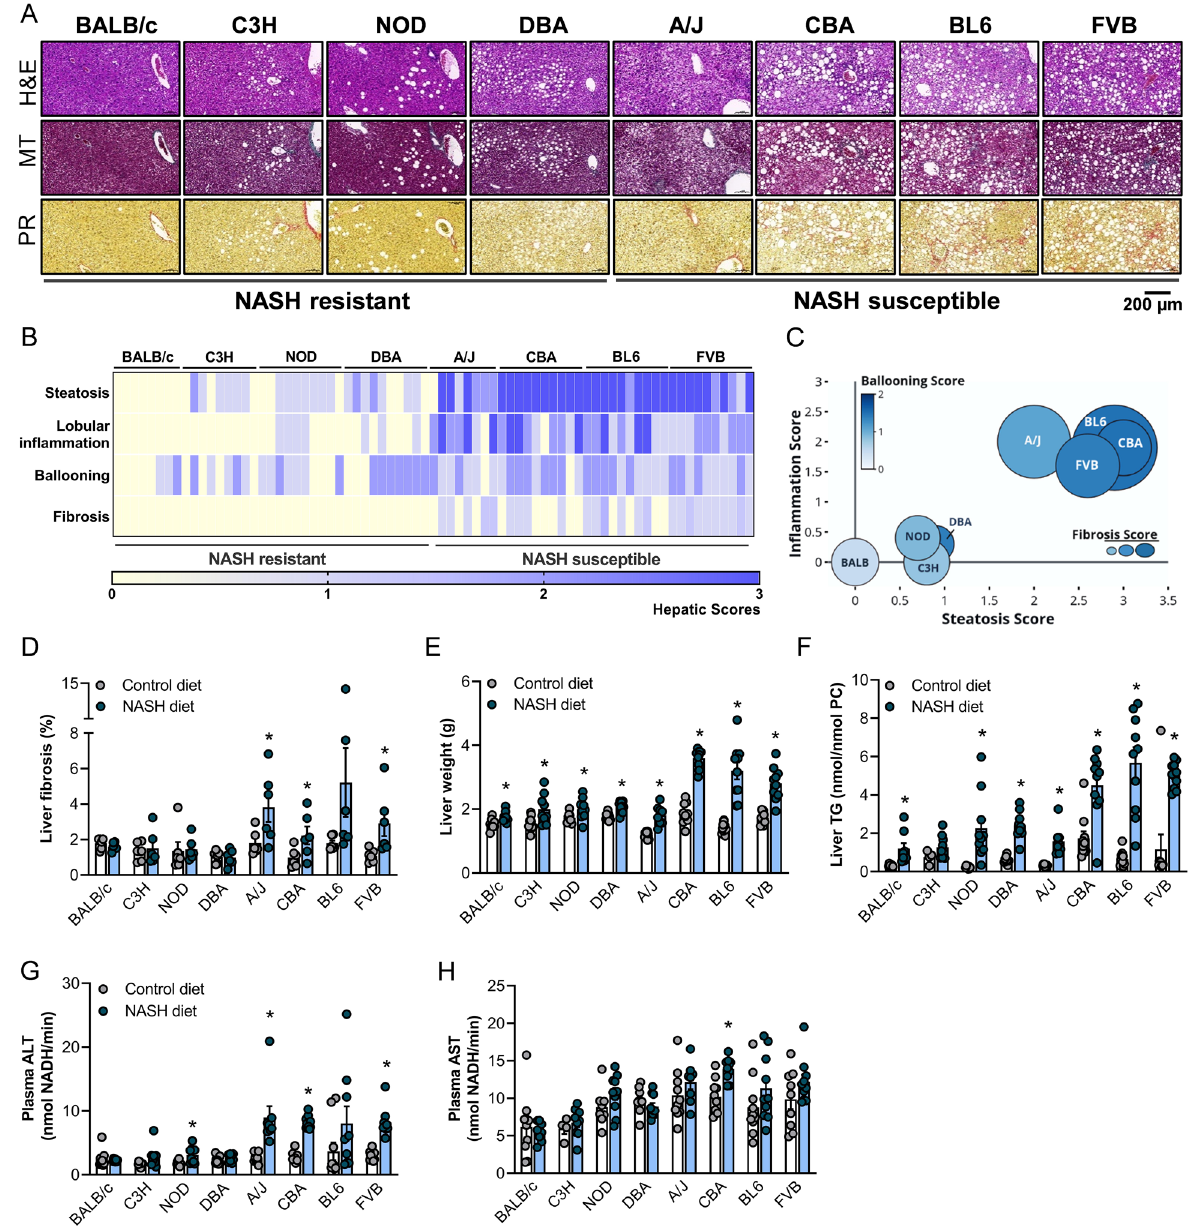
Figure 1. Liver histopathology assessment identifies NASH sensitive and NASH resistant mouse strains. ( A) Representative liver histology (H&E, Masson’s Trichrome and Picrosirius Red staining) in A/J, BALB/c, C3H/HeJ, C57BL/6J, CBA/CaH, DBA/2J, FVB/N and NOD/ShiLtJ mice fed a western-style diet, sorted by increasing prevalence of NASH and liver fibrosis. ( B ) Heat map analysis showing hepatic scores for steatosis, lobular inflammation, hepatocyte ballooning and fibrosis, ( C ) comparison of hepatic steatosis, inflammation, hepatocyte ballooning and fibrosis across all eight mouse strains, ( D ) percentage hepatic fibrosis (n = 6/group), ( E ) liver weight (n = 8–11/group), ( F ) liver triglyceride content (n = 7–10/group, n = 4 C3H Chow), ( G ) plasma alanine aminotransferase (ALT) (n = 8–10/group) and ( H ) plasma aspartate aminotransferase (AST) (n = 8–10/ group, n = 4 C3H Chow) activity, all sorted by increasing prevalence of NASH and liver fibrosis (as assessed by histopathological grading). Data are means ± SEM, *p < 0.05 vs. respective controls, as assessed by two-way unpaired